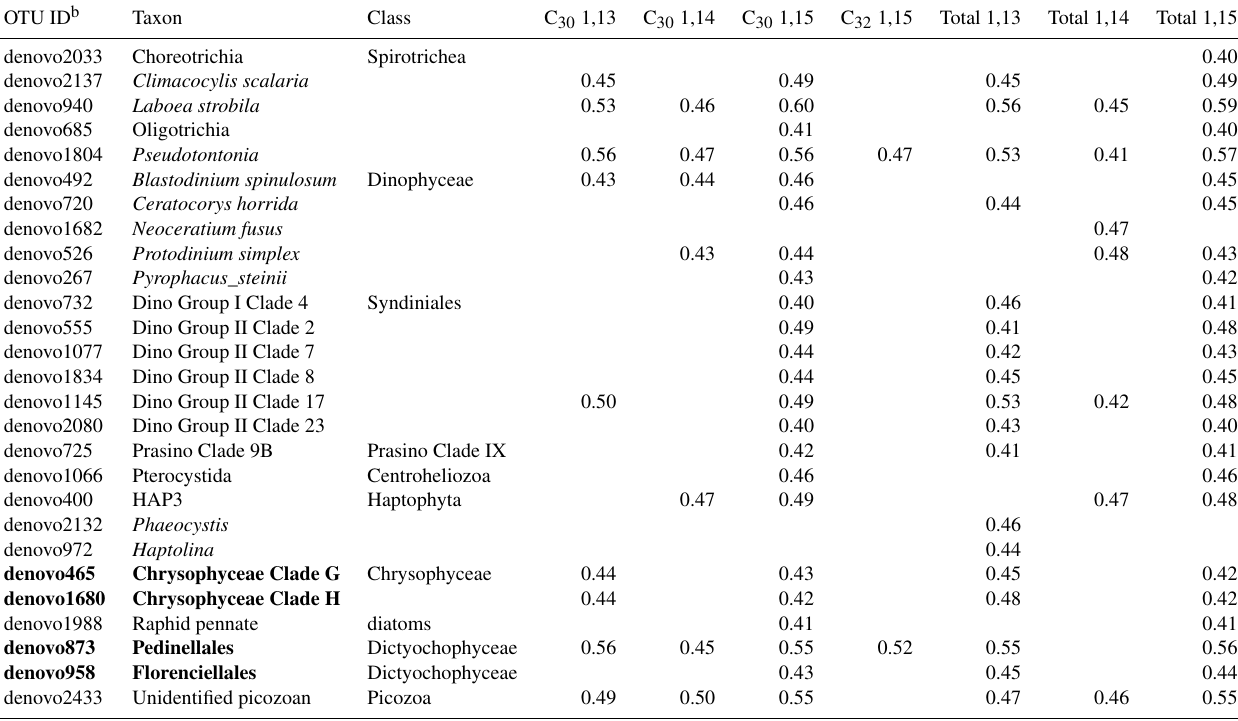
Table 3. Correlation coefficient ( r ) for the OTUs, representing 95% of the sequence identity, whose abundance was correlated a with the concentration of LCDs in SPM samples obtained in the HCC